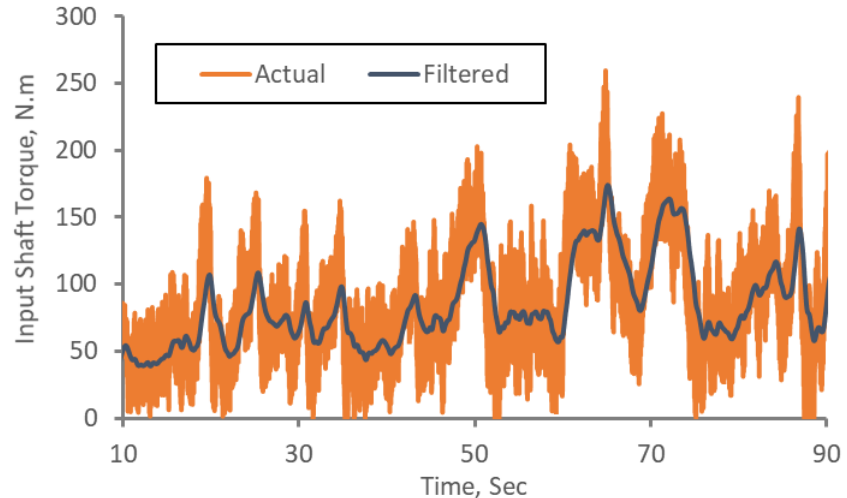
Figure 19. Measured and filtered input shaft torque during plowing operation without the control system.